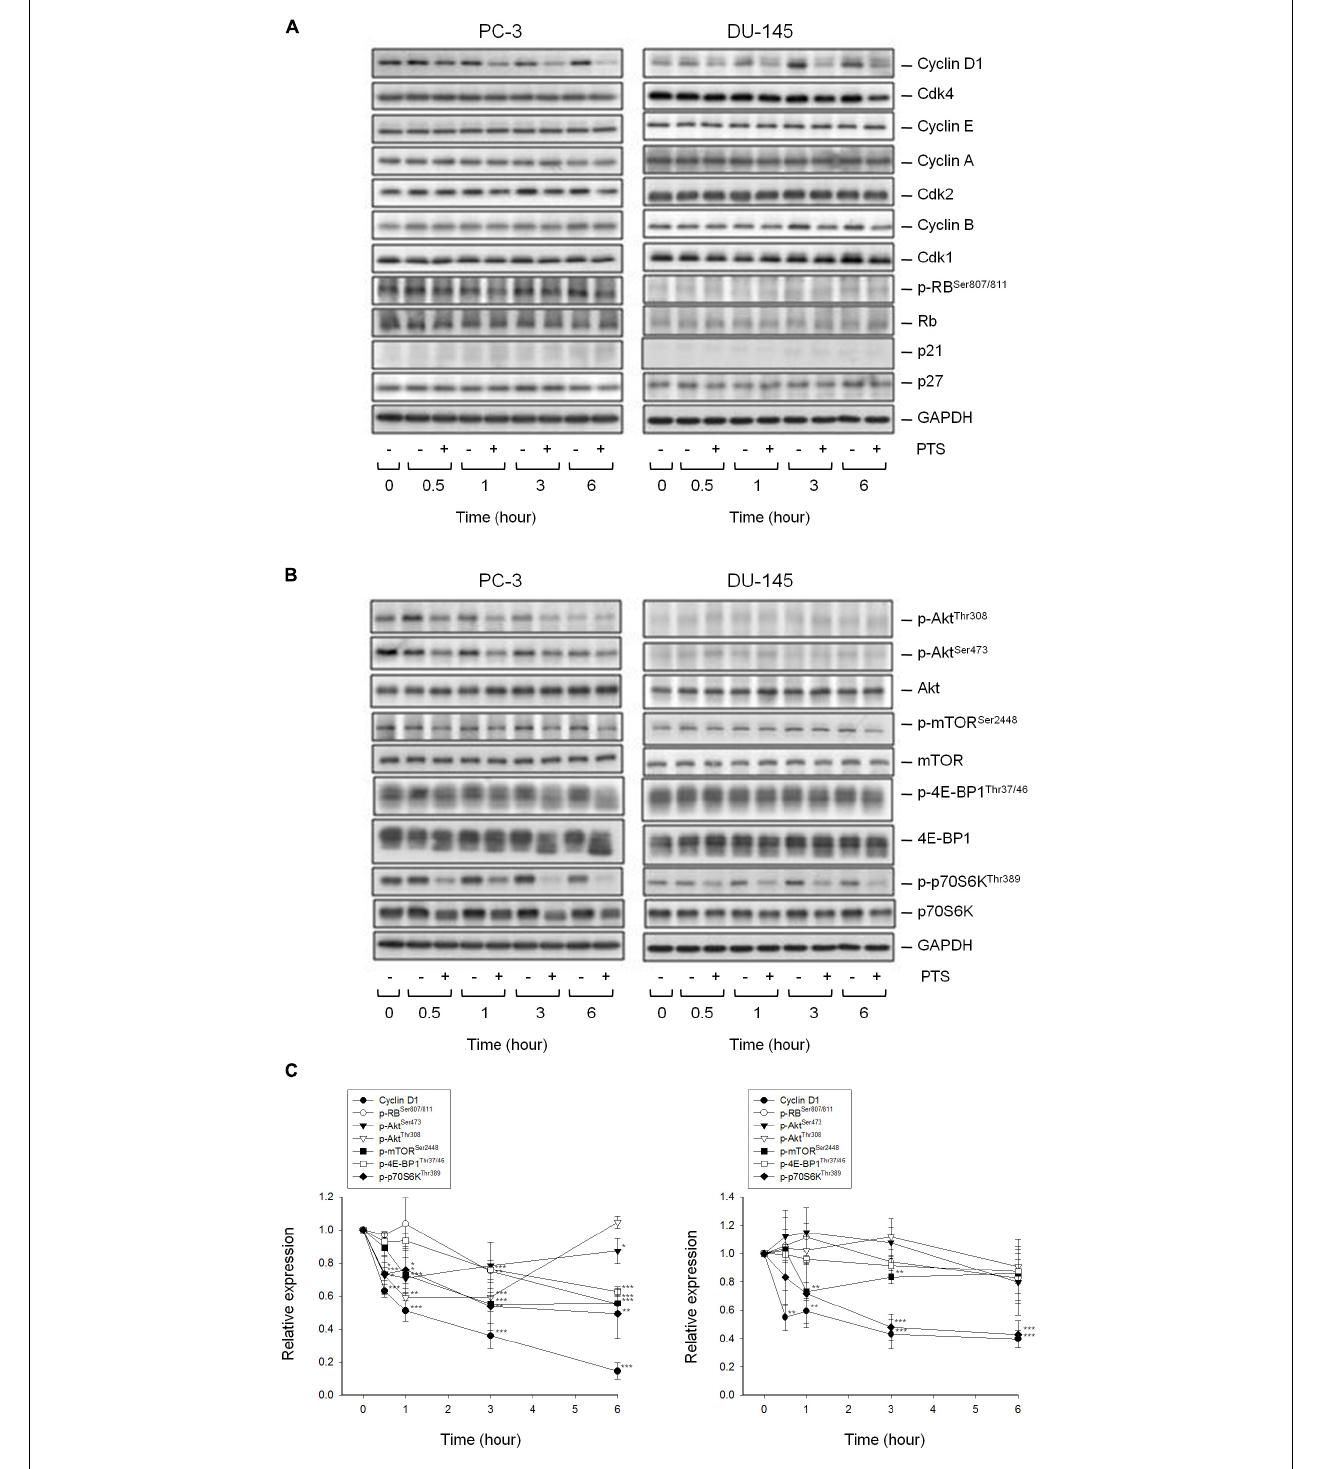
FIGURE 3 | Effect of PTS on the expression of cell cycle regulators and kinases. The cells were incubated in the absence or presence of 6 mM PTS for the indicated times. After treatment, the cells were harvested and lysed for the detection of protein expressions of cell cycle regulators (A) , and Akt/mTOR/p70S6K pathway signals (B) by Western blot analysis. The control GAPDH images are re-used in Figures 3A,B because they are the same experiment. The expression was quantified using Image Lab Software 6.0 (BIO-RAD) (C) . Data are expressed as mean ± SD of three determinations. ∗ P < 0.05, ∗∗ P < 0.01, ∗∗∗ P < 0.001 compared with the